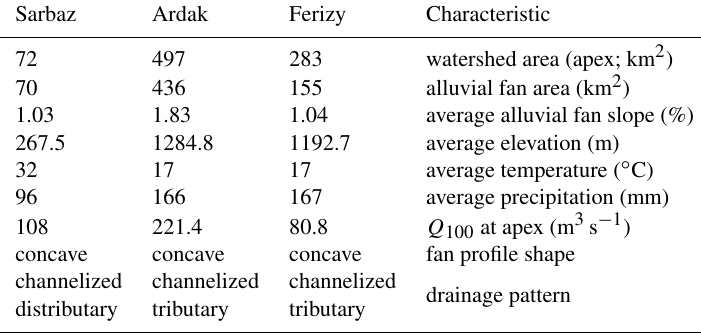
Table 3. The characteristics of three alluvial fans.